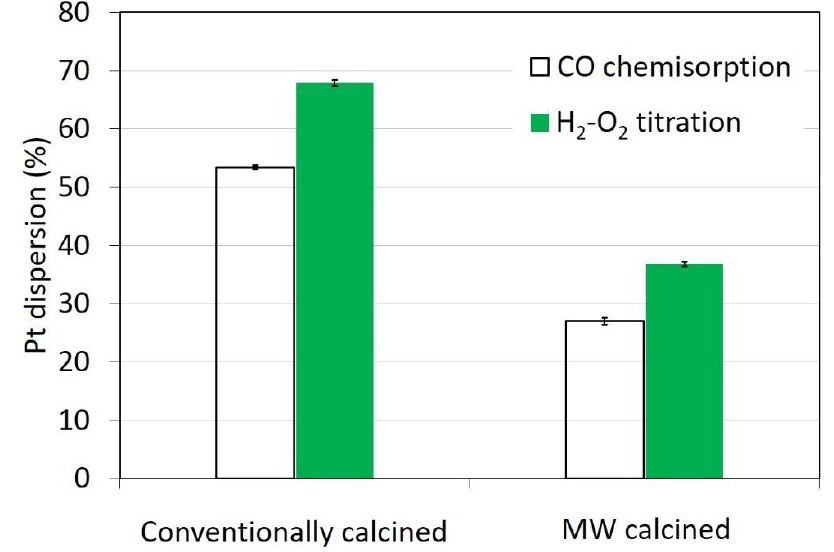
Figure 2. Comparison of Pt dispersion of samples conventionally calcined (600 °C, 2 h) and calcined by microwave irradiation (600 °C, 30 min). The dispersion was measured by CO chemisorption and H 2 –O 2 titration. Both samples were dried by microwave irradiation.